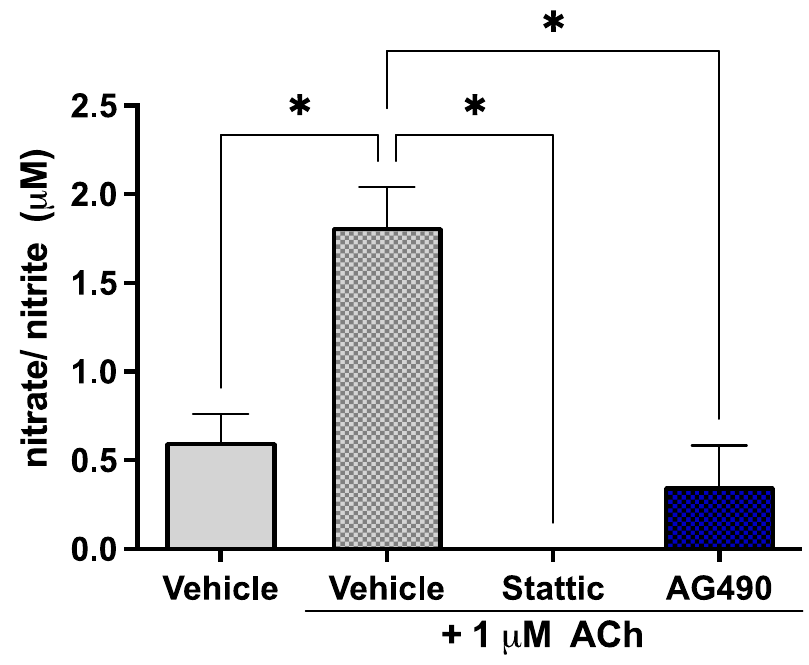
Figure 3. Inhibition of STAT3 abolishes endothelial response to acetylcholine. ECs were treated with Stattic (5 µ M) or AG490 (25 µ M) for 12 h, following which they were stimulated with 1 µ M ACh for 30 min. Medium was collected and analyzed for the metabolites of nitric oxide: nitrate and nitrite. ACh increased nitrate/nitrite release by ECs; treatment with either inhibitor abolished this response to ACh, n = 4; *, p < 0.05, one-way ANOVA. Data are presented as mean ± SEM.